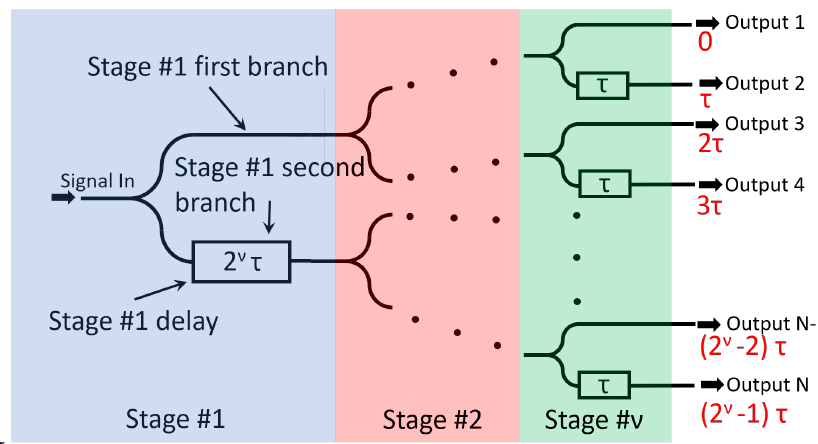
Figure 15. Schematic of the tree type network with N